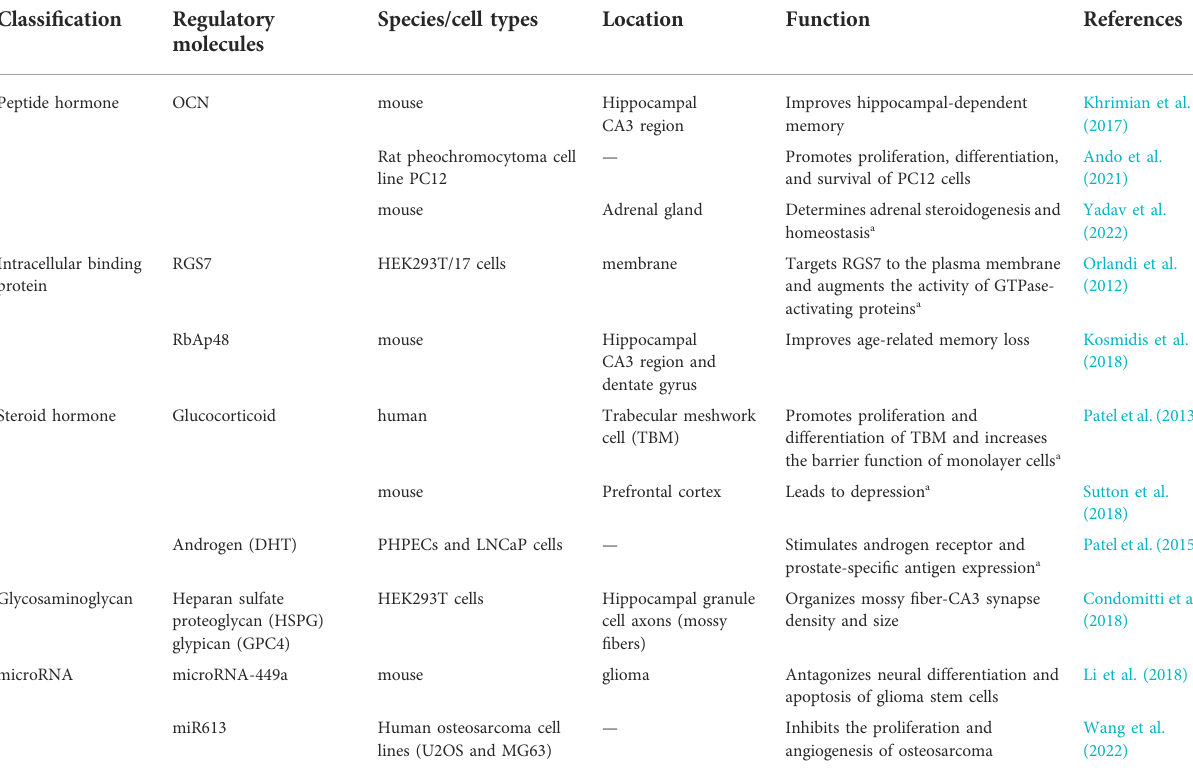
TABLE 1 Overview of GPR158 regulatory